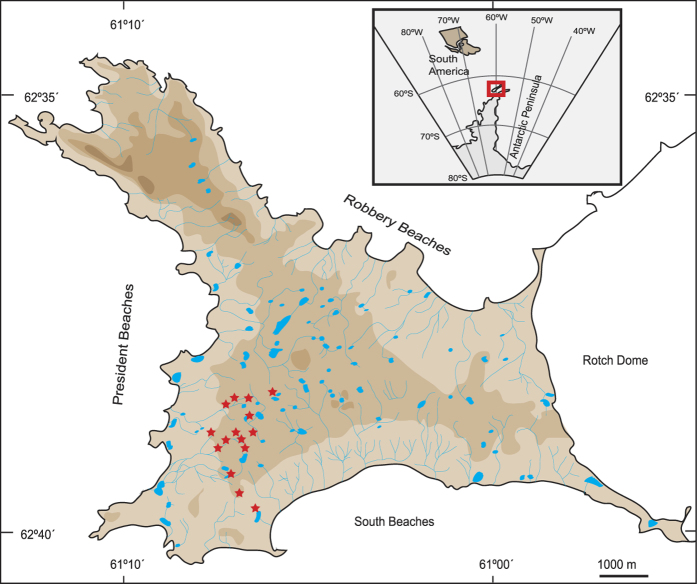
Study-site location.Site map showing the sampling area located in the Byers Peninsula (Livingston Island, South Shetland Islands, Antarctica). Red stars mark surveyed blighted spots. The map is based in the geomorphological map of Byers Peninsula7 modified with data from co-authors and shading layers mark 25 m intervals on altitude difference.